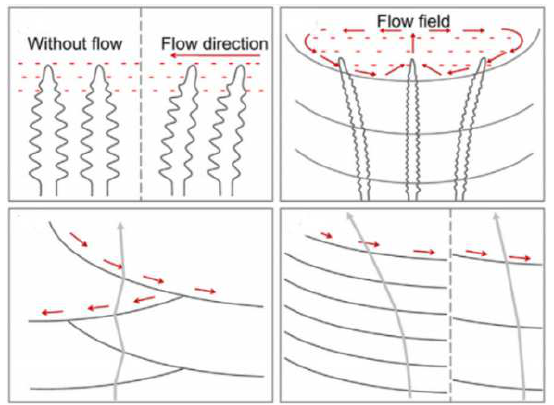
Figure 7. Schematic diagram of the deflection trend of the LMD process [65].